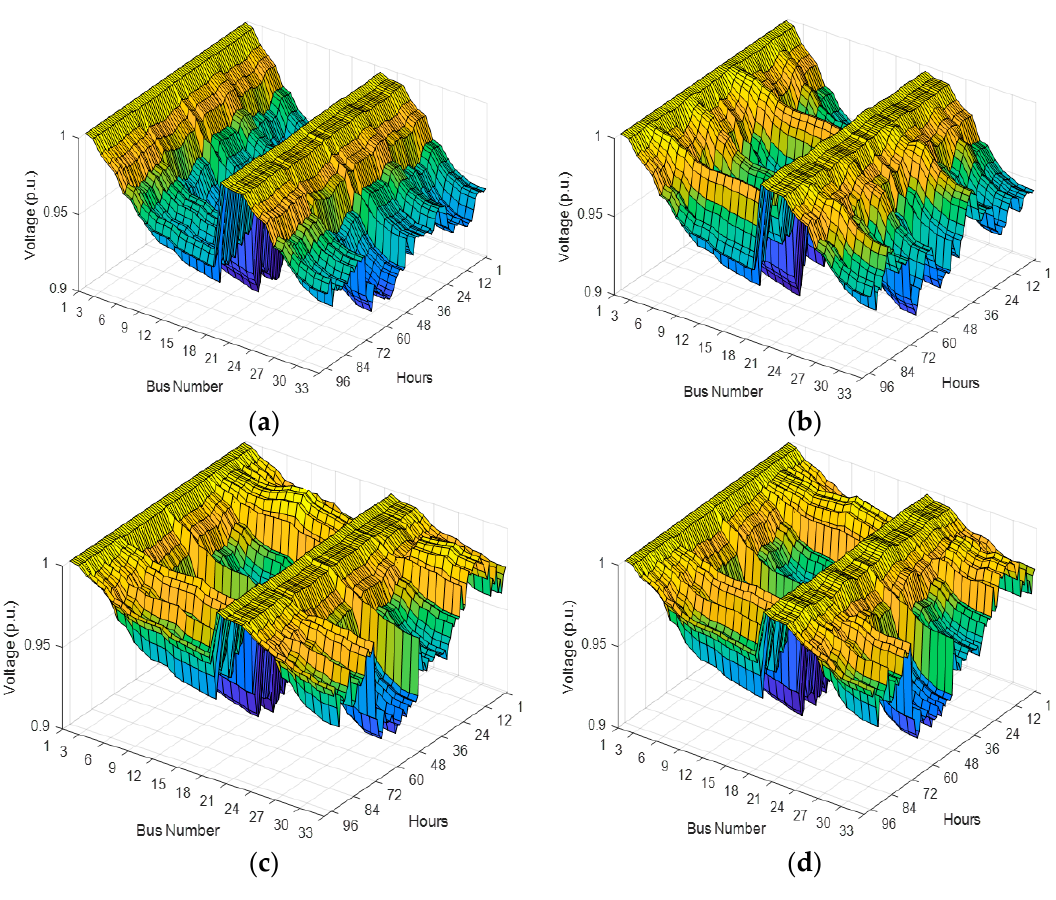
Figure 14. Seasonal voltage profiles variation for the IEEE 33-bus: ( a ) Basic case; ( b ) PVDG case; ( c ) WTDG case; ( d ) Hybrid PVDG-WTDG case.